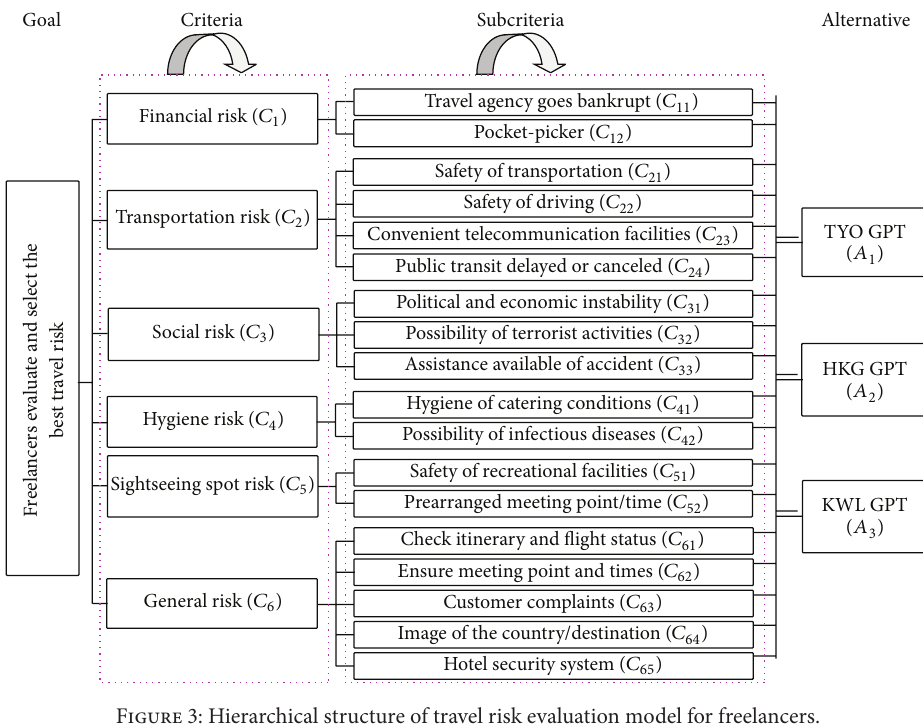
Figure 3: Hierarchical structure of travel risk evaluation model for freelancers.